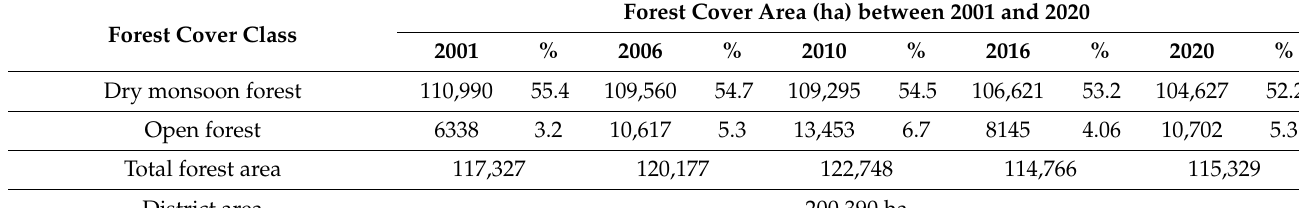
Table 3. Forest cover areas and their percentages for the total district.